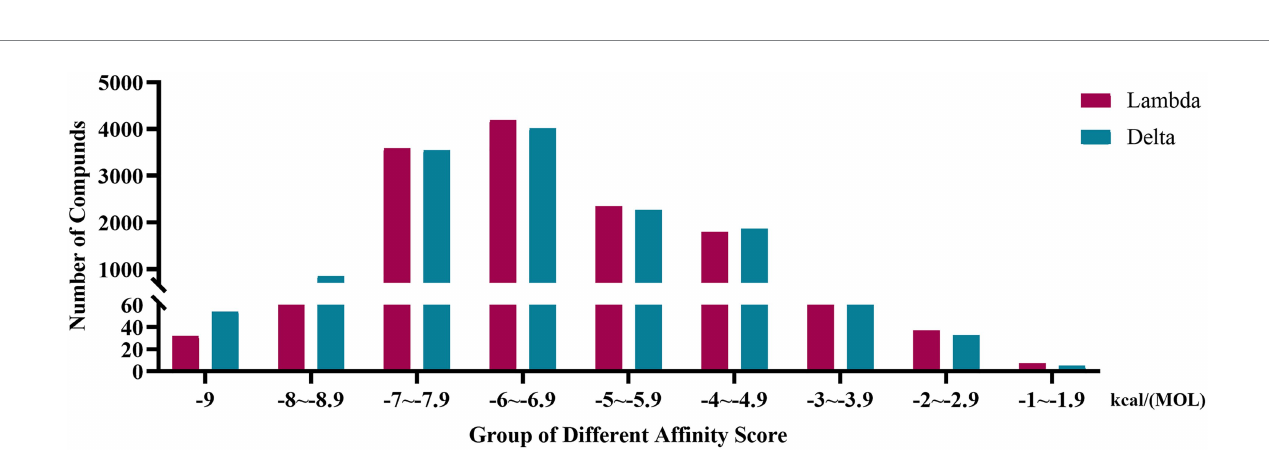
FIGURE 2 Distribution bar graph of the affinity score of small molecular compounds with Lambda and Delta